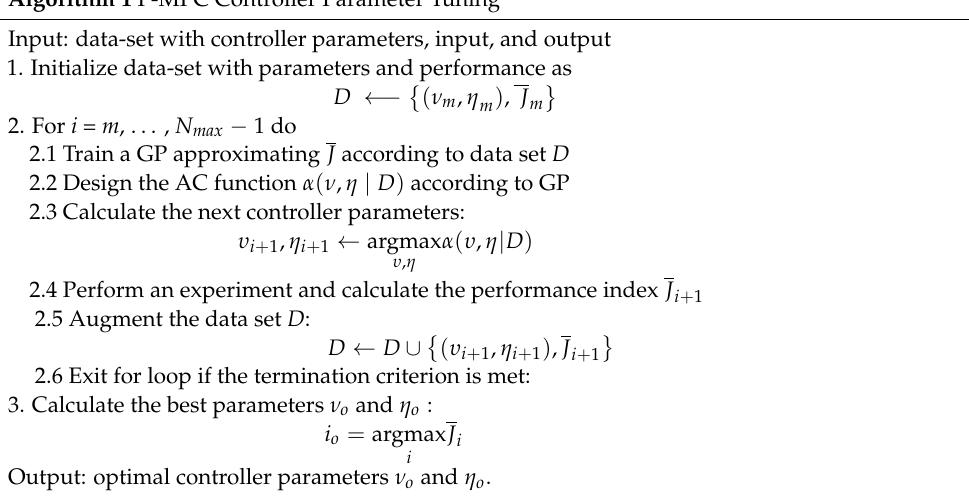
Algorithm 1 P-MPC Controller Parameter